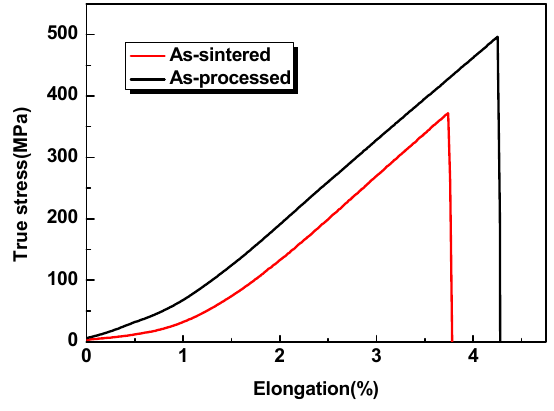
Figure 4. Room temperature tensile curves of the Ti ‐ 22Al ‐ 25Nb alloy.